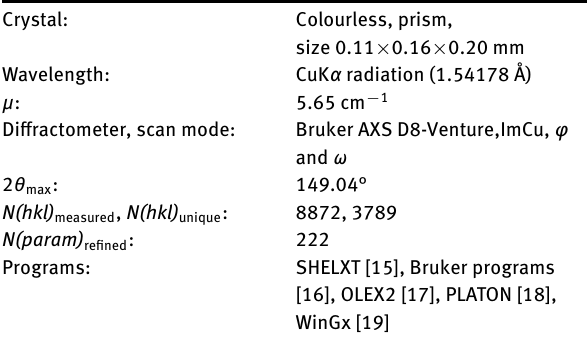
Table 1: Data collection and